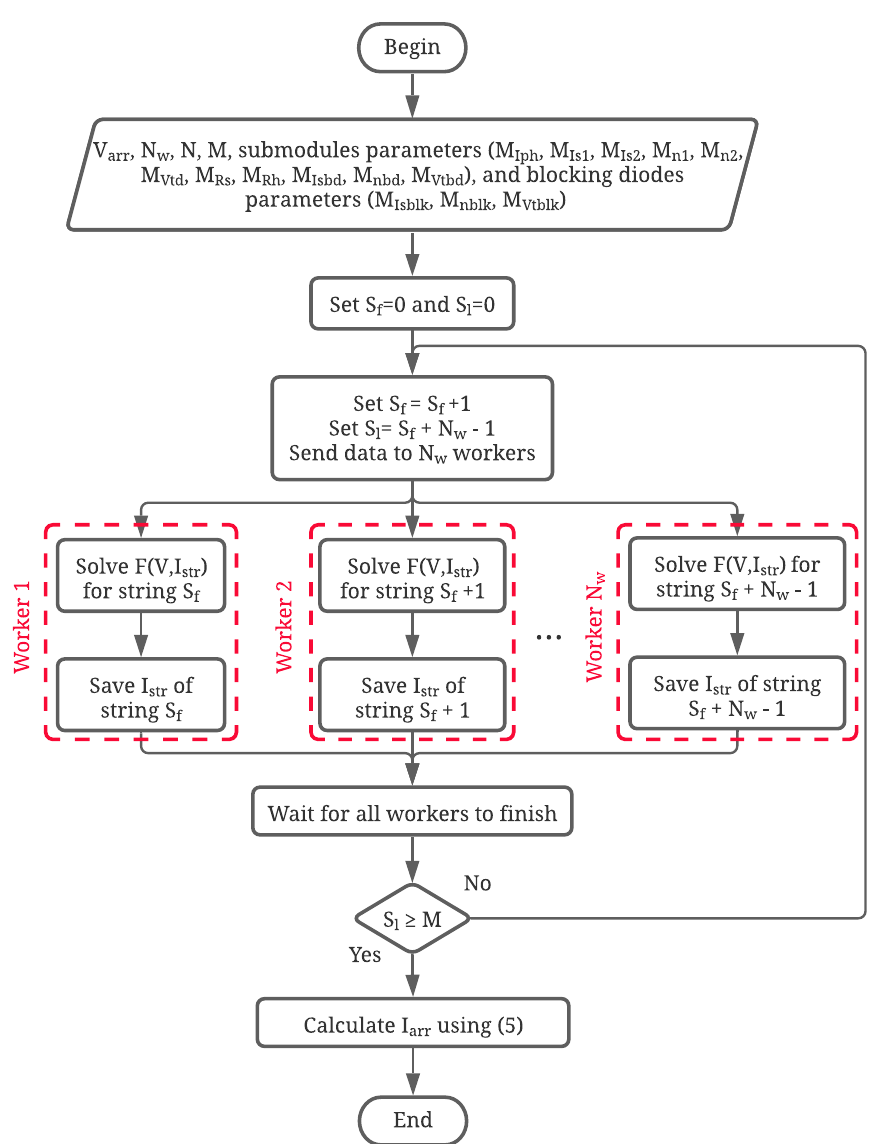
Figure 3. Flow chart of the solution of an M × N Series-Parallel array using parallel